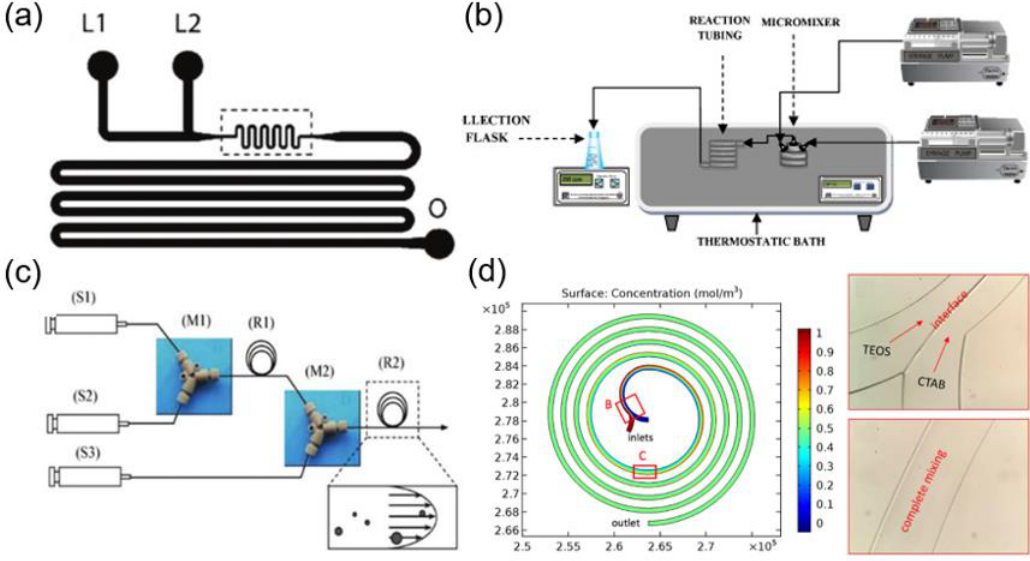
Figure 1. ( a ) Schematic illustration of microfluidic channels containing two liquid inlets (L1 and L2) and one outlet (O) for the preparation of silica nanoparticles (reproduced from [23], with permission from the American Chemical Society, 2004). ( b ) Experimental setup for the continuous synthesis of nanoparticle (reproduced from [24], with permission from the Elsevier, 2011). ( c ) Schematic diagram of microfluidic reactor systems with (S1) syringe for tetramethoxysilane (TMOS), (S2) syringe for 1 mM HCl, (S3) syringe for polyethylenimine (PEI) polymer in Tris–HCl buffer solution, (M1) and (M2) PEEK Y-shape mixers, (R1) reaction tube for hydrolysis, as well as (R2) reaction tube for silica precipitation (reproduced from [25], with permission from Elsevier, 2011). ( d ) Simulation and experimental results of reactants mixing in the spiral microchannel (reproduced from [26], with permission from Springer Nature, 2017).